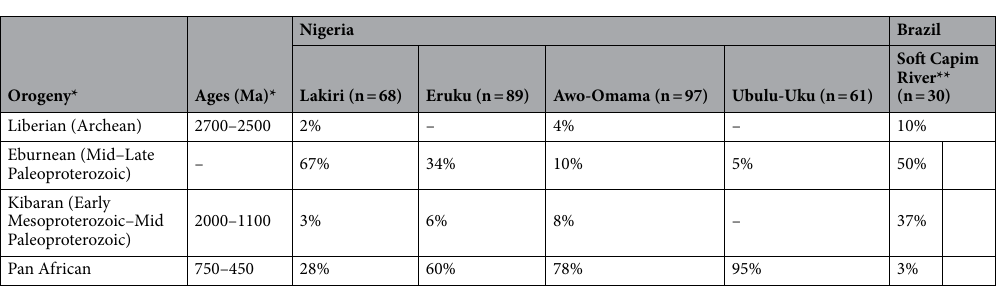
Table 4. Percentages of U–Pb ages of detrital zircon grains (using ≤ 10% discordance) within the studied Cretaceous–Paleogene/Neogene kaolins. * 14 ; ** 43